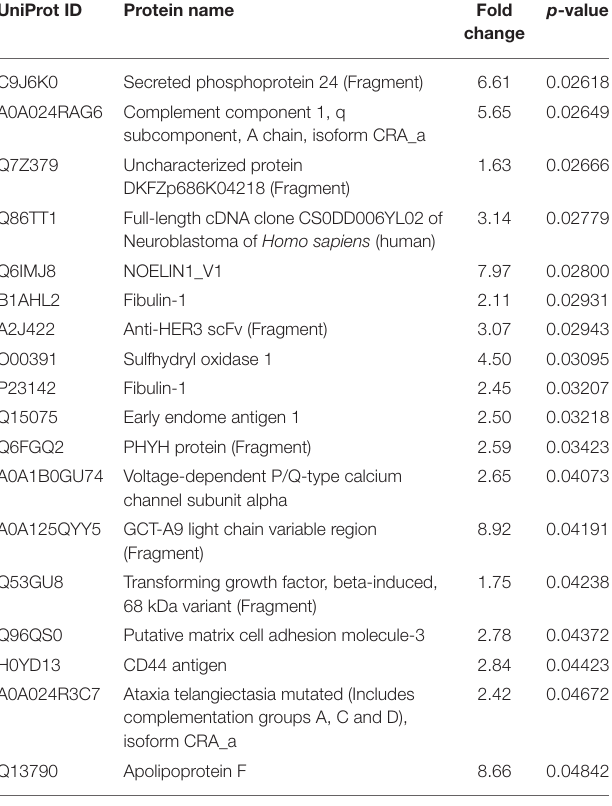
TABLE 3 | The list of a total of 57 differentially expressed proteins at < 0.5 or > 1.5 of fold changes with p <